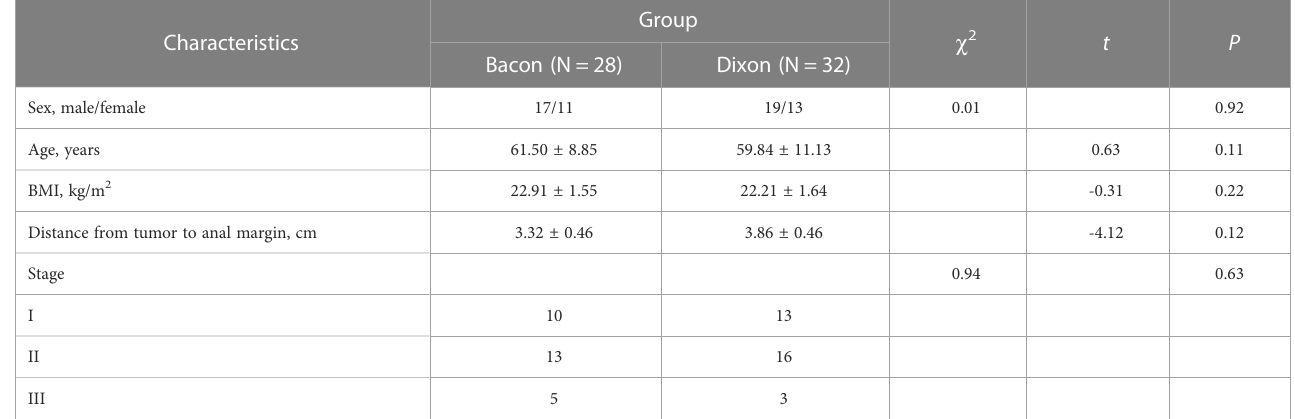
TABLE 1 Patient